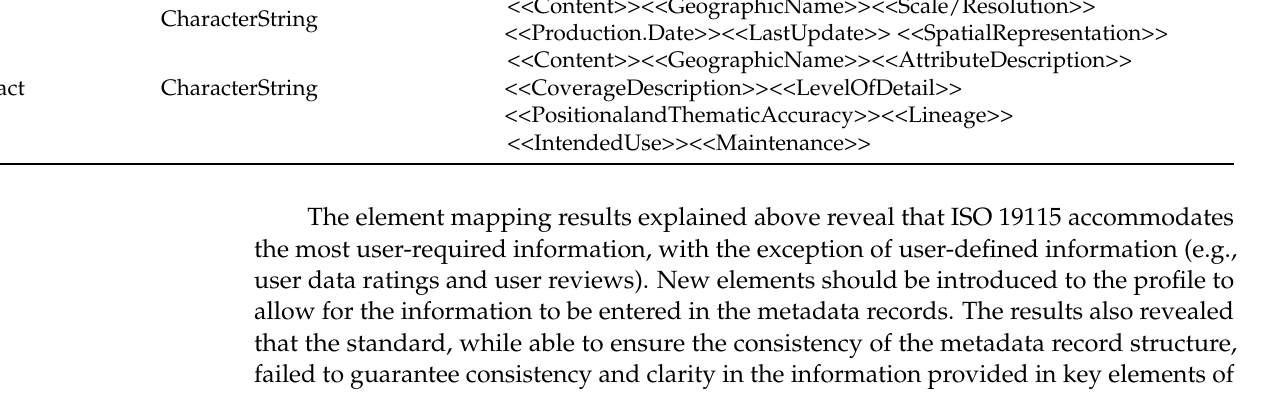
Table 19. Proposed information in the domain/definition for the titles and abstracts in a user-oriented profile. Element Data